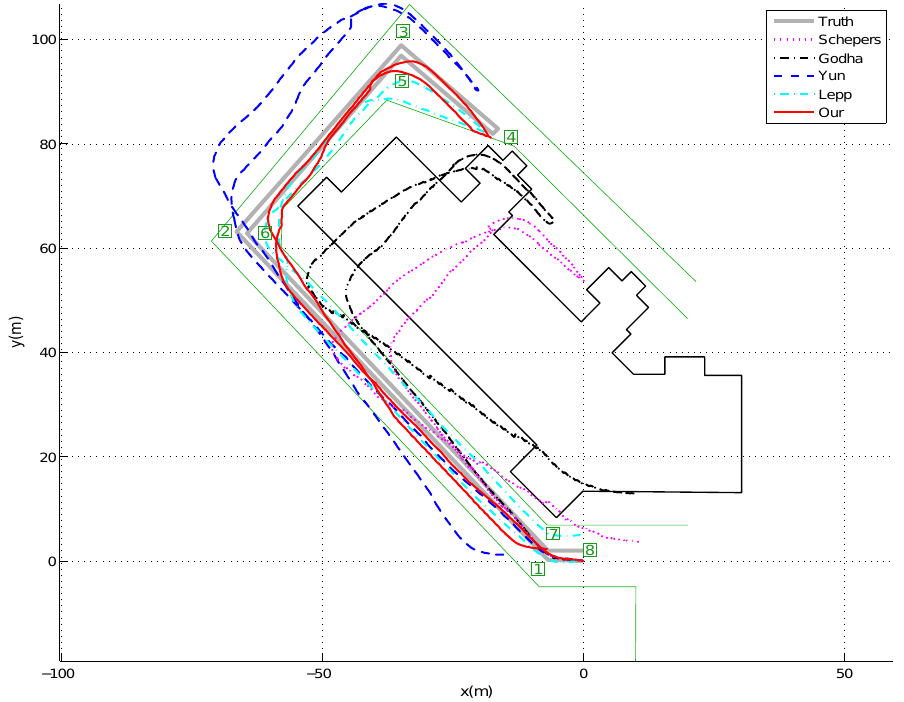
Figure 6. One example of the position estimation for outdoor experiments with a walking speed at about 0.75 m/s. The actual positions of the 8 critical points were marked by the square number plates. It is obvious that the integration of ZUPT and map information can further improve the position estimation